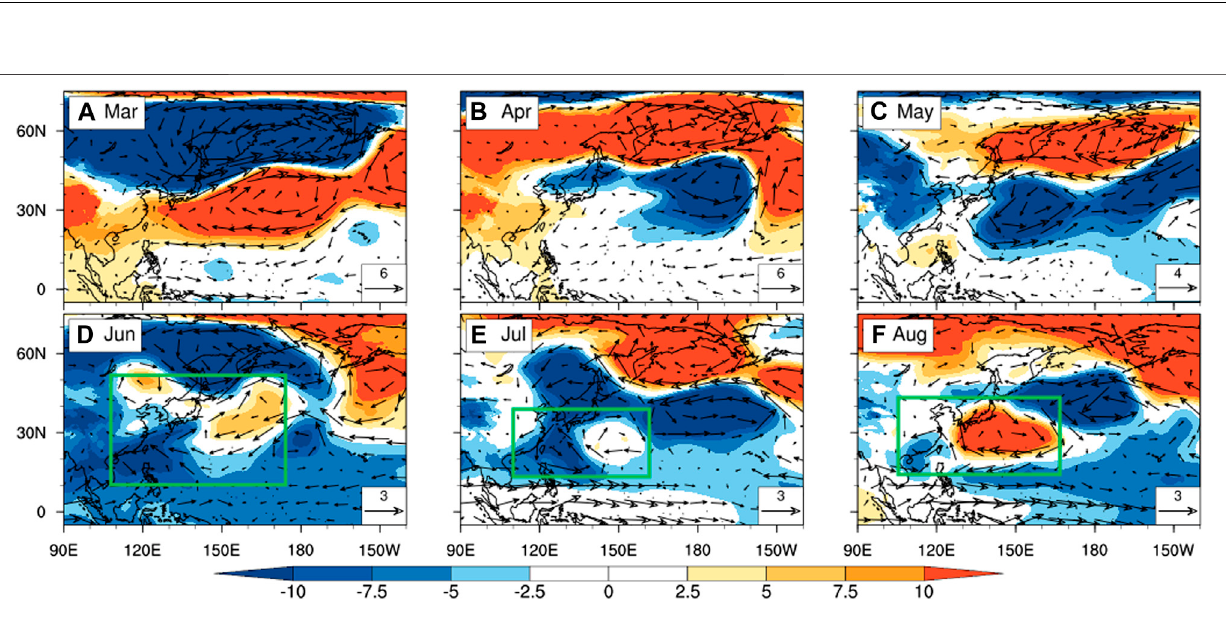
FIGURE11| Compositedifferencesof (A) March, (B) April, (C) May, (D) June, (E) July,and (F) Augustmean850-hPageopotentialheight(shading;unit:gpm)and 850-hPa wind anomalies (vector; unit: m s − 1 ) between the extreme high and low years of U850 EJ,3 . Green rectangles in (D – F) indicate the anomalous eastward shift of subtropical high over the WNP in positive U850 EJ,3